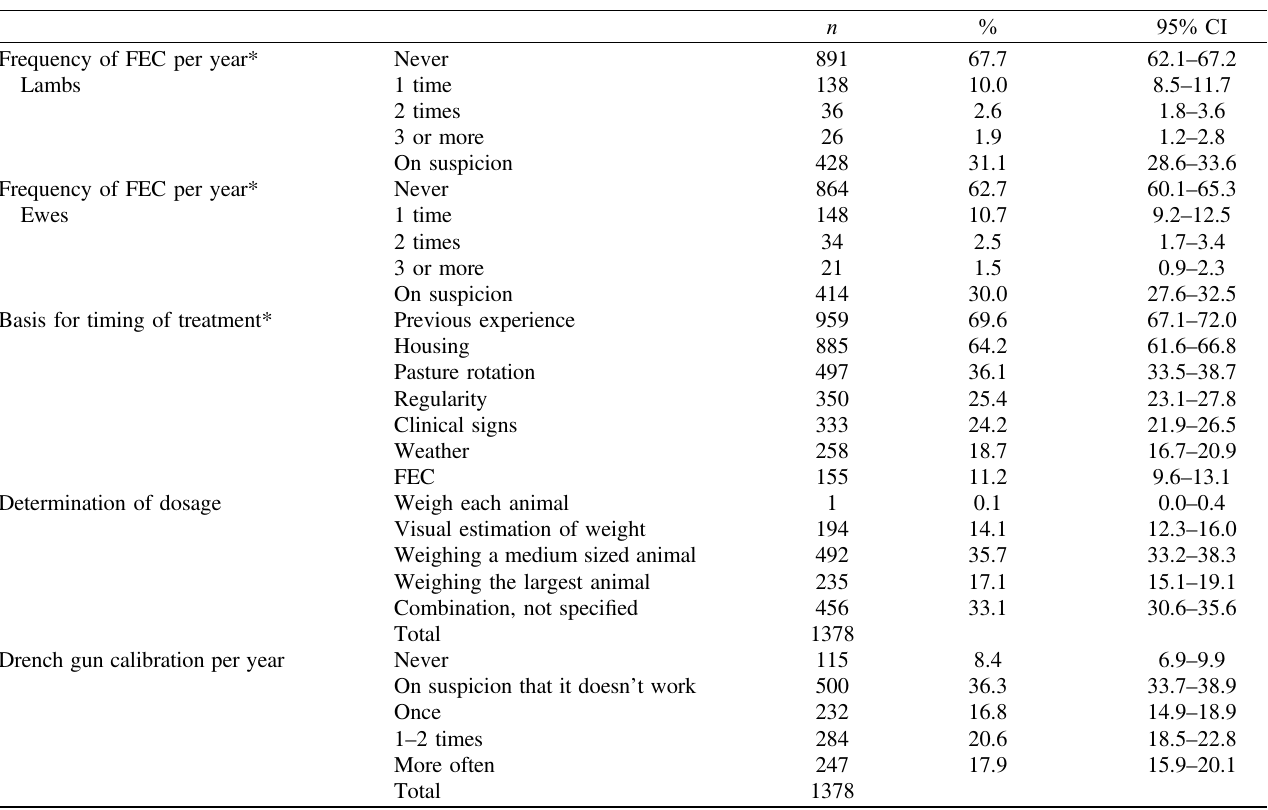
Table 2. Descriptive data of parasitological analysis (FEC = fecal egg count), timing of treatment, and dosage regime of the fl ocks included in this study ( n =